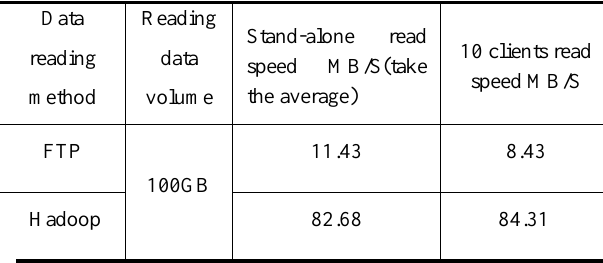
Table 2 Efficiency analysis